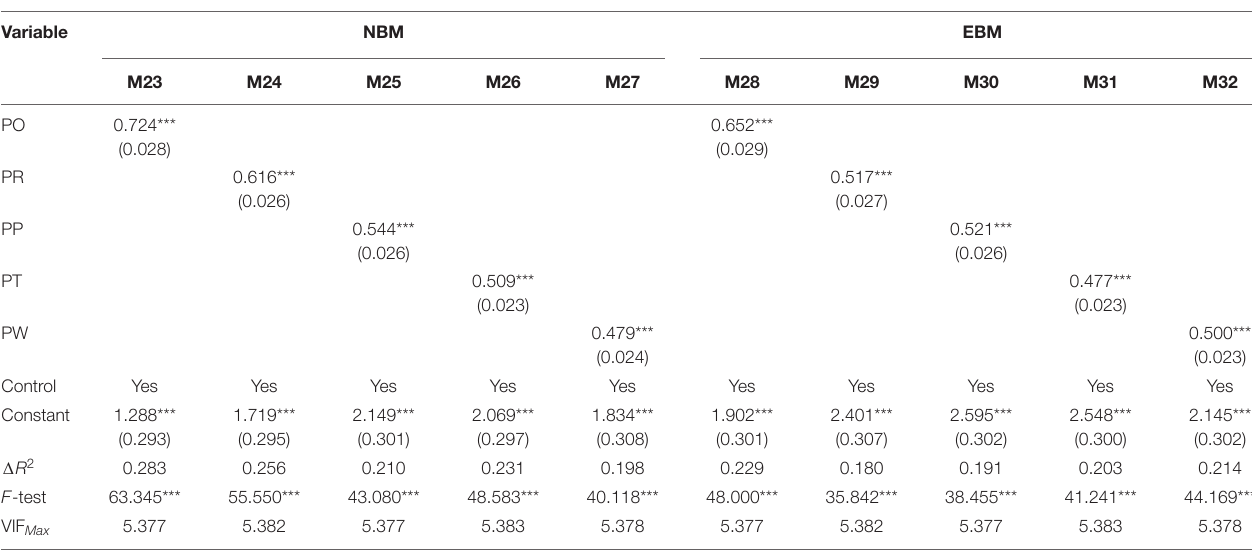
TABLE 5 | Adding control variable